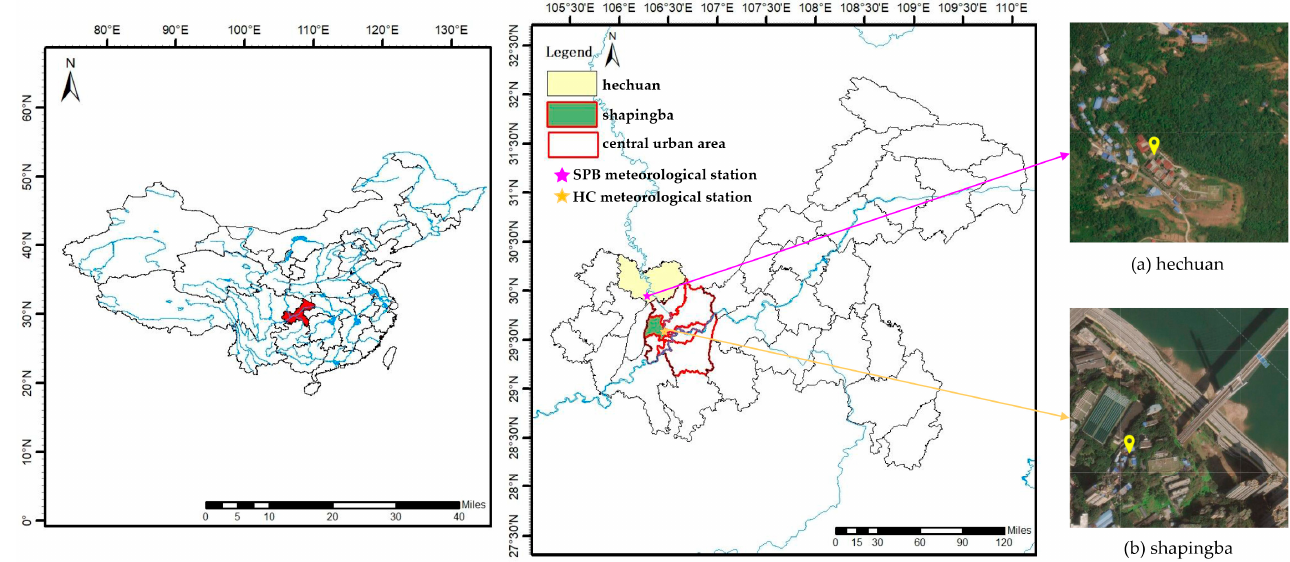
Figure 1. Location in Chongqing and distribution of meteorological stations: ( a ) Hechuan meteoro- logical station; ( b ) Shapingba meteorological station.